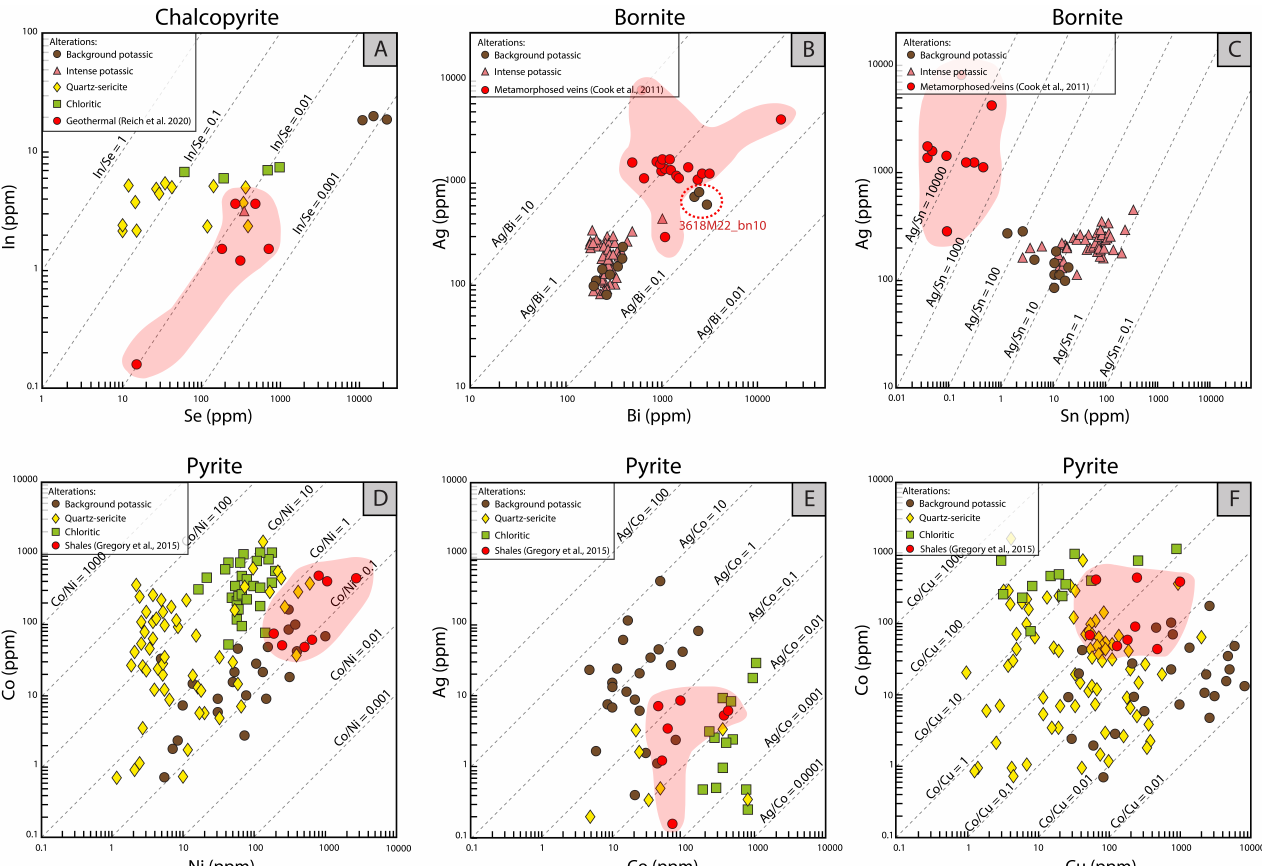
Figure 9. Elemental concentration scatterplots of sulfides as a function of alteration from the Chuquicamata Underground mine. ( A ) In vs. Se scatterplot for chalcopyrite. ( B ) Ag vs. Bi scatterplot for bornite. In the red circle, outlier of bornite sample 3618M22_bn10 that is not associated with chalcocite/digenite/covellite. ( C ) Ag vs. Sn scatterplot for bornite. ( D ) Co vs. Ni scatterplot for pyrite. ( E ) Ag vs. Co scatterplot for pyrite. ( F ) Co vs. Cu scatterplot for pyrite. Data are plotted in parts per million (ppm) on a logarithmic scale. Only LA-ICP-MS data included. In ( A – F ), comparisons with published data from un-mineralized and distal systems are provided (red